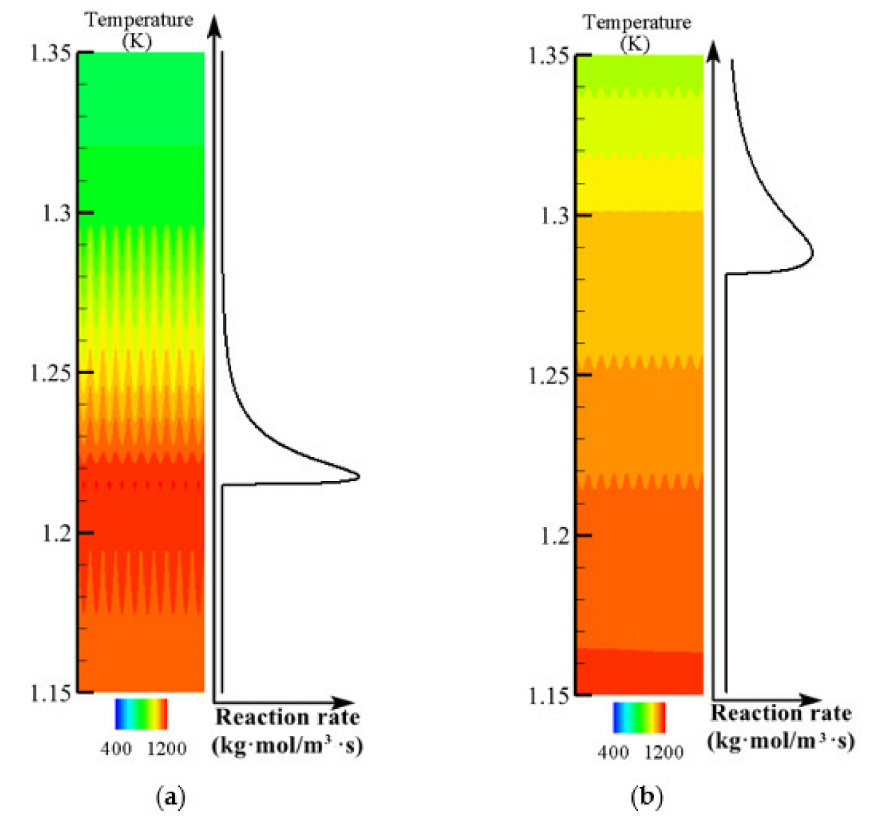
Figure 17. Comparison of temperature field in the reaction zone with X CH flow = 800 m 3 /h; ( b ) Inlet flow = 200 m 3 /h.